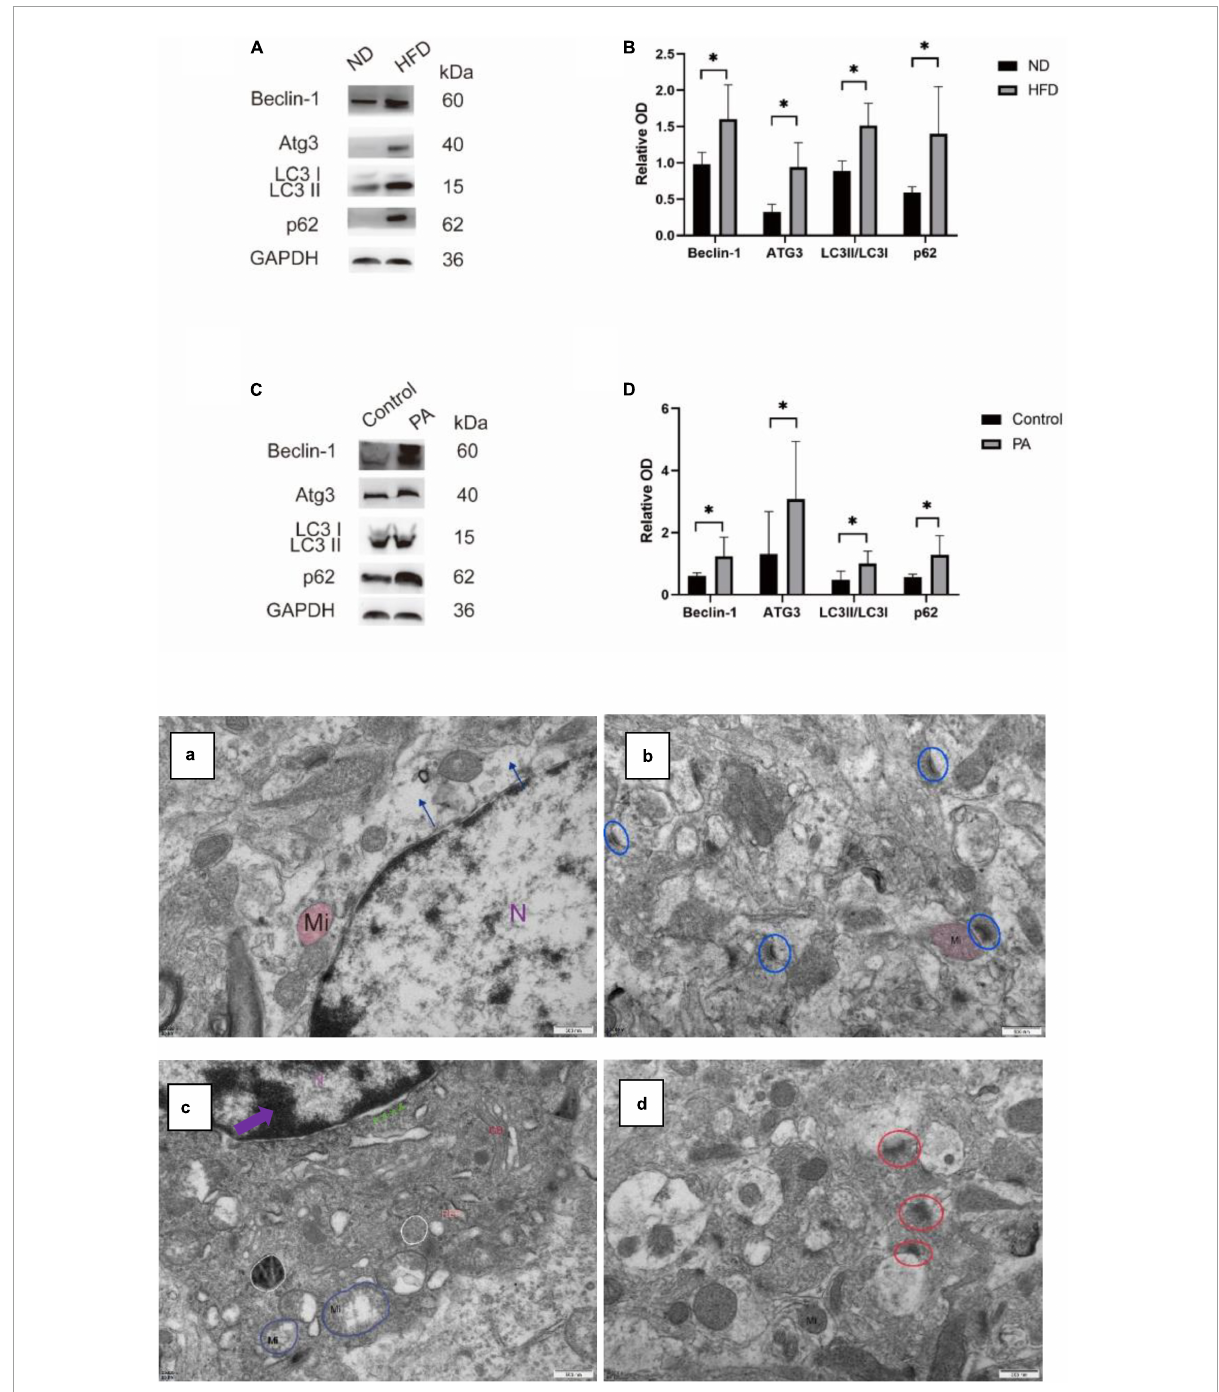
FIGURE8 The expression levels of autophagy-associated proteins and the ultrastructure of autophagosomes in the hippocampus of mice under an electron microscope. (A,B) Representative western blotting bands of Beclin-1, ATG3, LC3, and P62 in the hippocampus of mice and their quantification. (C,D) BV2 cells treated with PA medium (100 mM) showed increased expression of Beclin-1, ATG3, LC3, and P62 compared with the CON group (ND, n = 4 mice; HFD, n = 4 mice). (E) Alterations in hippocampal ultrastructure were examined by transmission electron microscopy. (a) The gliocyte lost its cytosol (blue arrow) in ND. N, nucleus; Mi, mitochondria, × 30000. (b) The synaptic structure was intact, with normal histological structure in ND (blue circle). (c) The nucleus condensed, and the chromosomes gathered to assemble chromatin (purple arrow) and widened the nuclear gap (green arrow) and mitochondrial mild swelling (blue circle) and autophagosomes (white circle) in the HFD group. RER, rough endoplasmic reticulum, GB, Golgi bodies × 30000. (d) The structure of presynaptic membrane and synaptic gap is not clear in HFD (red circle) × 30000, scalar bar = 500 µ